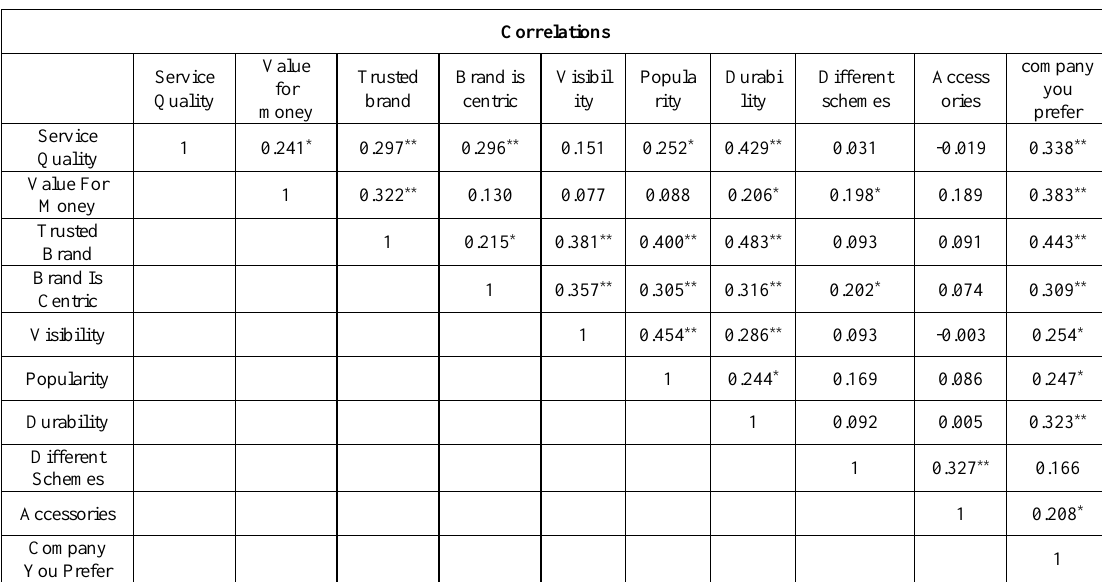
Table 2, represents the respective values of the goodness-of-fit values for -2 log likelihood, Cox and Snell R 2 and Nagelkerke R 2 for the last iteration (i.e. step